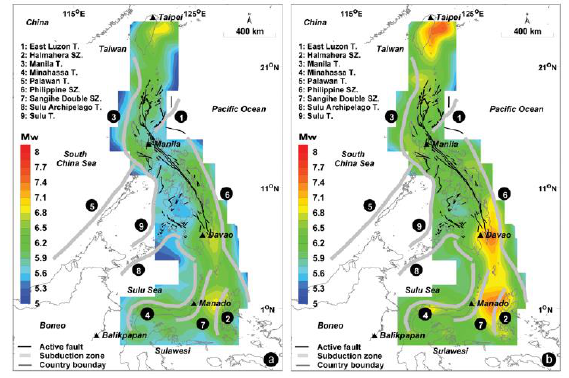
Figure 1. Map of the Philippines showing the maximum earthquake magnitude likely to be generated in each area in the next (a) 5, (b) 10 years respectively.